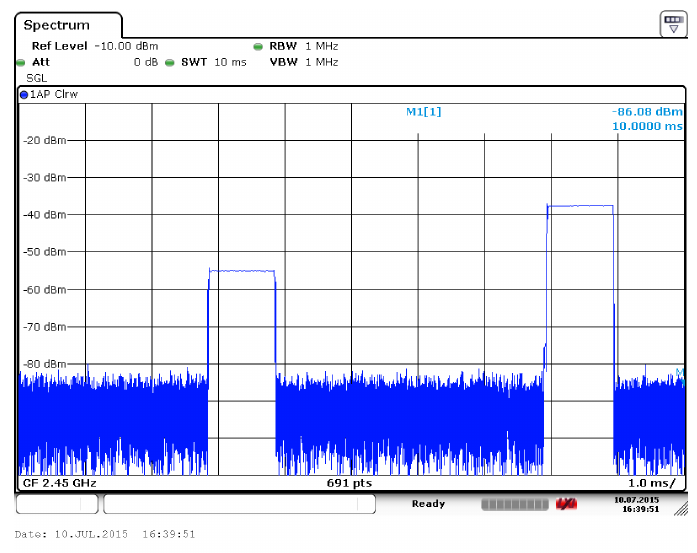
Figure 2. Rohde & Schwarz FSV40 Screenshot for a bilateral channel estimation transmission with 5 ms transmit-receive turnaround